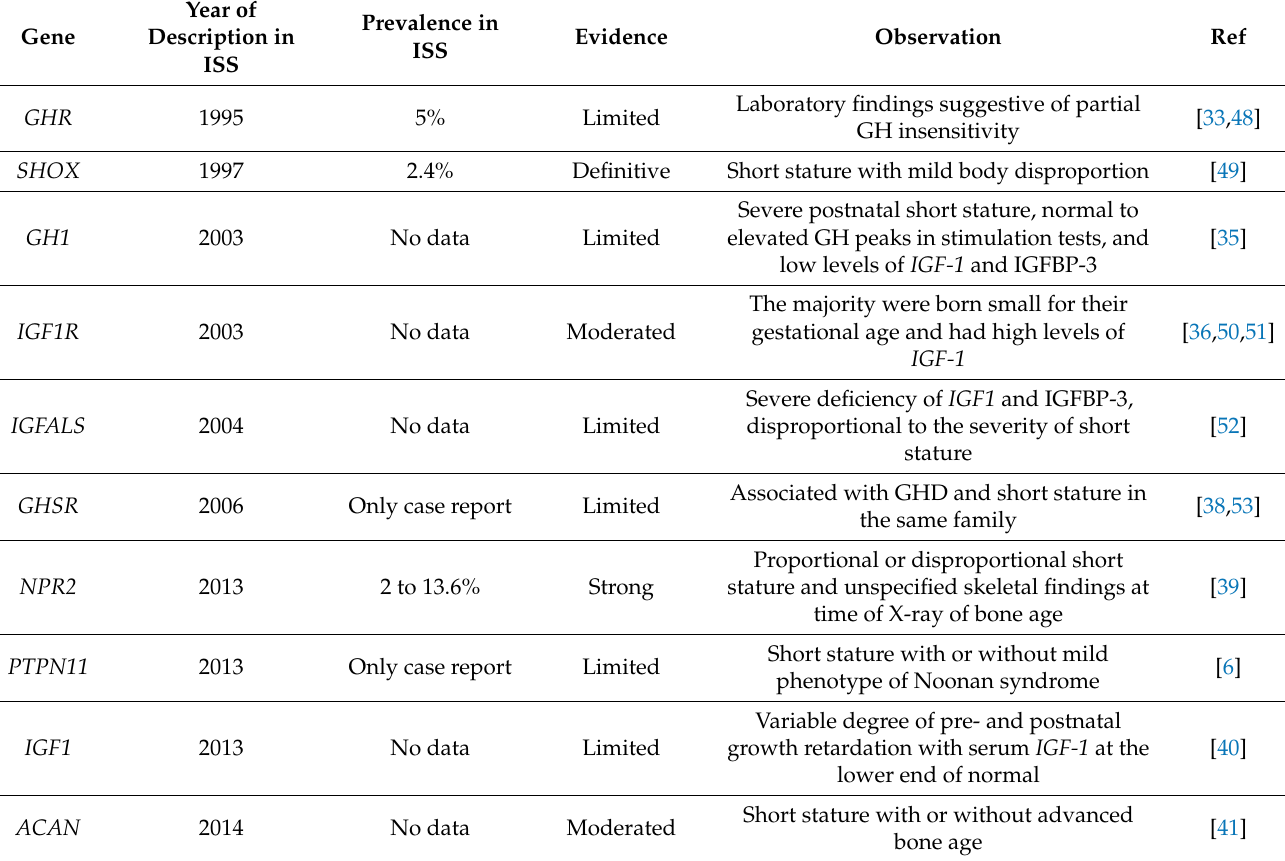
Table 1. The genes related to “idiopathic short stature” as a monogenic